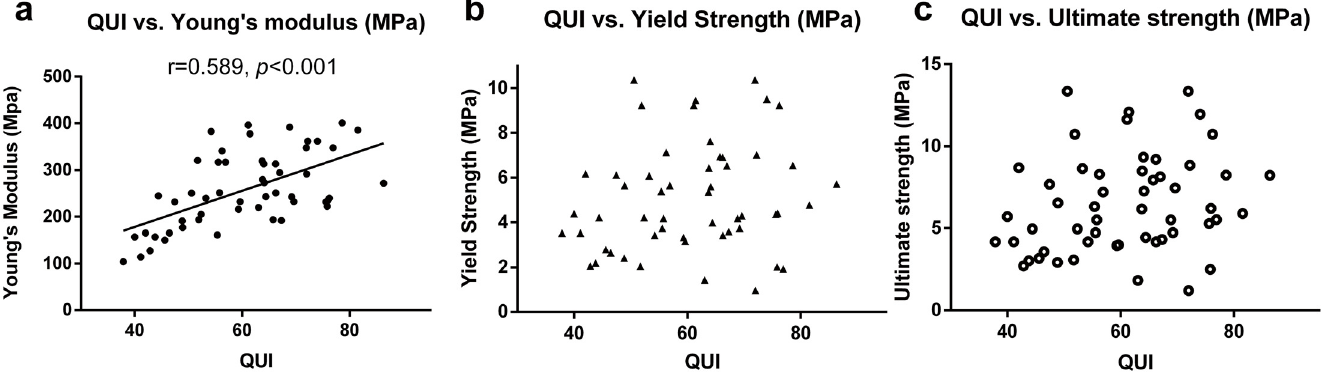
Fig 4. Pearson ’ s correlation of stiffness with mechanical properties of the primary compressive trabecular (PCT) column in the femoral head. The QUI significantly correlated with Young ’ s modulus of the PCT column of the femoral head (Fig 4a). However, no significant correlation was noted with the yield strength (Fig 4b), or ultimate strength (Fig